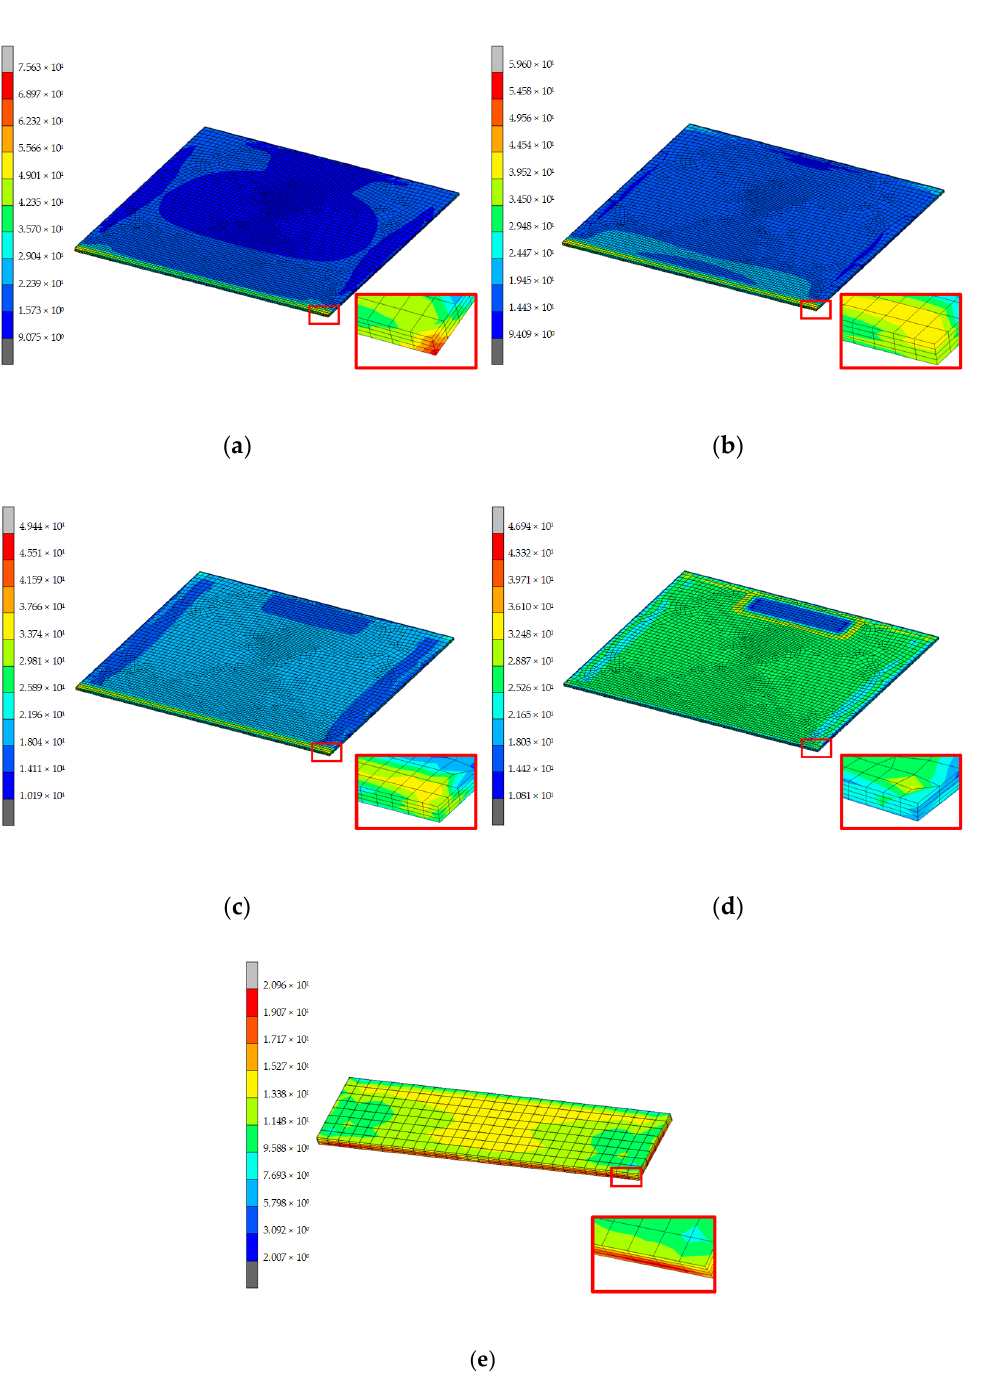
Figure 13. Stress cloud picture of each layer of stacked chips. ( a ) Chip-1 stress cloud picture; ( b ) Chip-2 stress cloud picture; ( c ) Chip-3 stress cloud picture; ( d ) Chip-4 stress cloud picture; ( e ) Chip-5 stress cloud